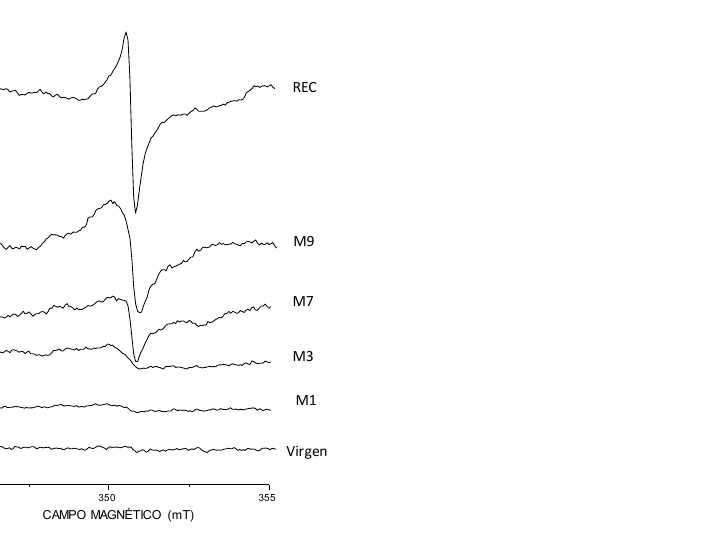
Figure 8. FTIR spectra. Left: virgin sample and samples extruded 1 (R1), 4 (R4) and 7 (R7) times. Right: recycled samples without irradiation and irradiated at 100 kGy in both air and argon.